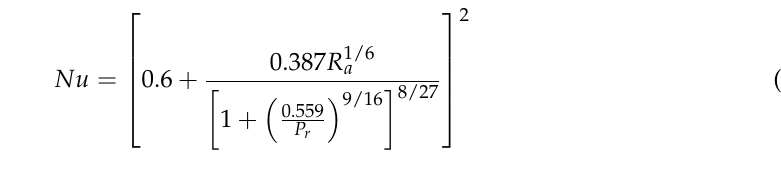
Figure 6. Distribution of the von Mises stress in the cable in MPa ( right in elastic range; left in plastic range).